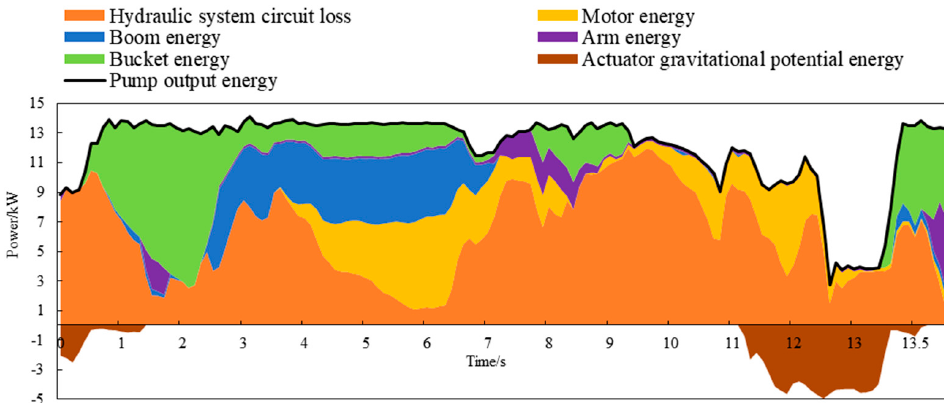
Figure 22. The operation system energy flow.